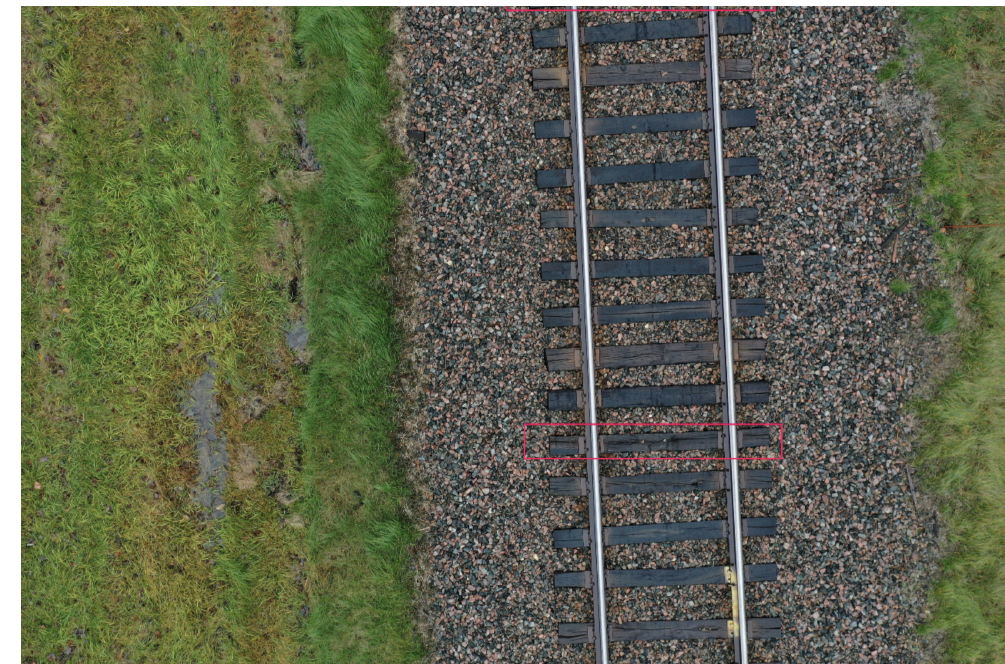
Figure 8. Example of a broken